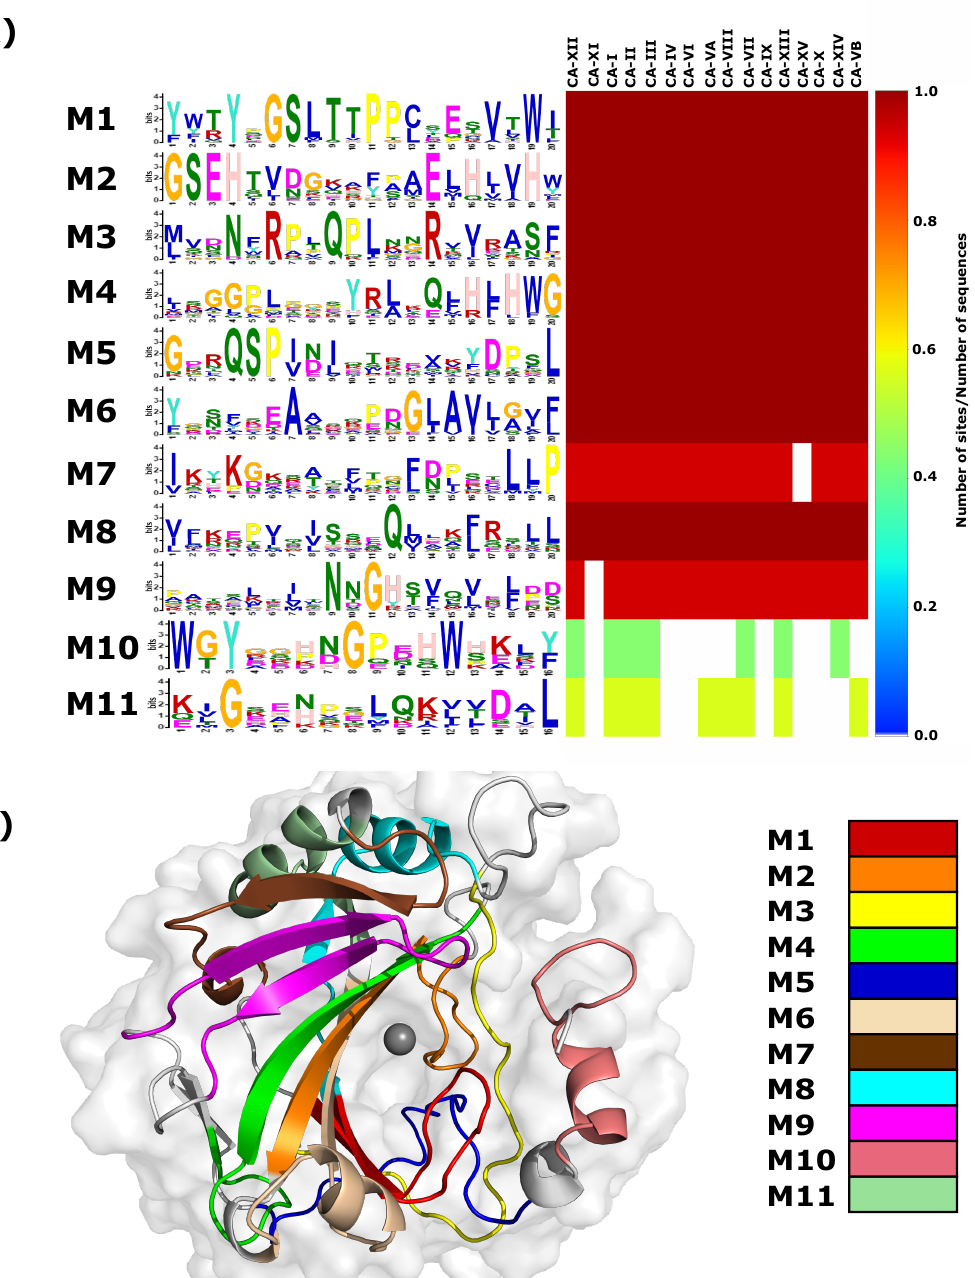
Figure 2. Motifs present in the α -CA family. ( A ) Web logo presenting residue conservation within a motif in each sequence and a heat map showing motif conservation as the number of motif sites per total number of protein sequences. A value of zero is for motifs that are not conserved in any sequence, whereas a value of 1 shows that motif exists in all selected sequences. The prefix ’M’ represents the word “motif”. ( B ) Motif location in 3D space within CA-II. The grey sphere represents the Zn 2 + . Representations were generated using Schrödinger Maestro and